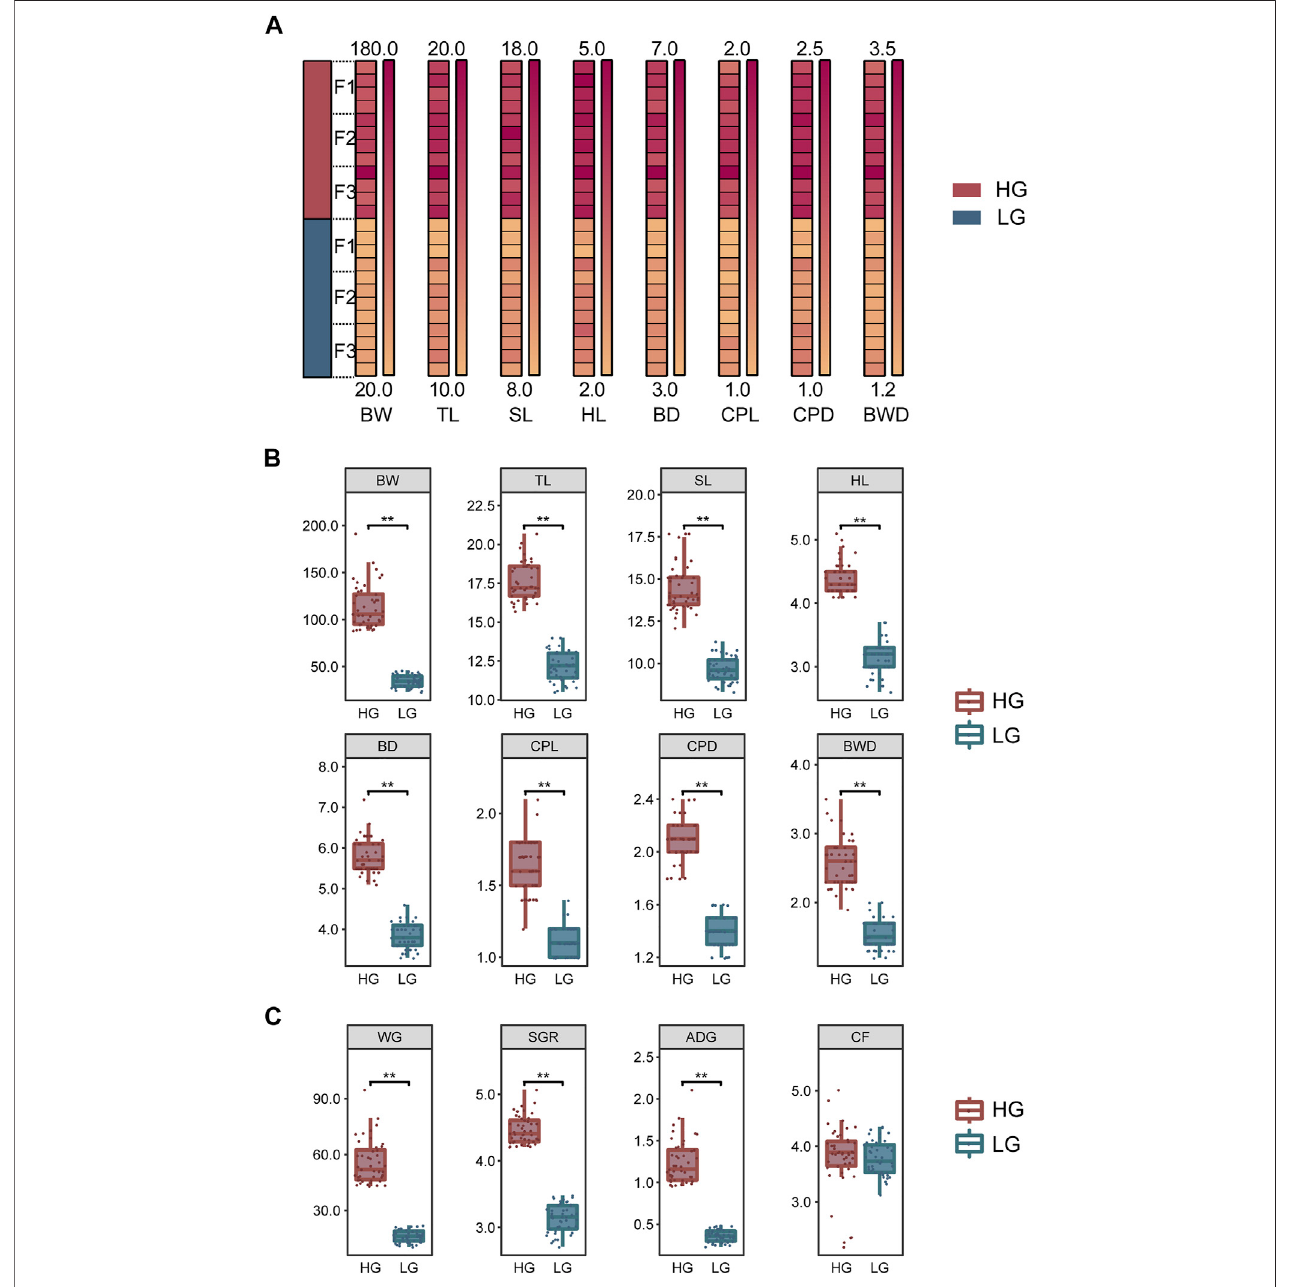
FIGURE 1 | Growth traits and analysis of signi fi cant differences among samples. (A) Differences in growth traits of the Nile tilapia used for transcriptome sequencing. (B) Signi fi cant differences in growth traits between the higher growth (HG) and lower growth (LG) groups of tilapia ( n = 45, each group). (C) Differences